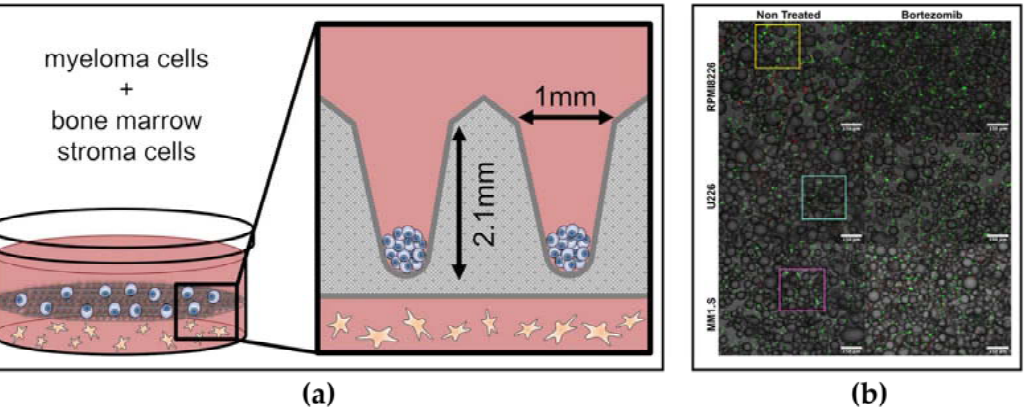
Figure 4. ( a ) MM cells and BM stroma cells in 3D coculture [131], Copyright 2022, Journal of Cancer Research and Clinical Oncology . ( b ) Live (green) and Dead (red) states on 10% AA microgels of three MM cell lines untreated or exposed to BTZ 4 nM for 72 h [133], Copyright 2022, Biomaterials Advances .